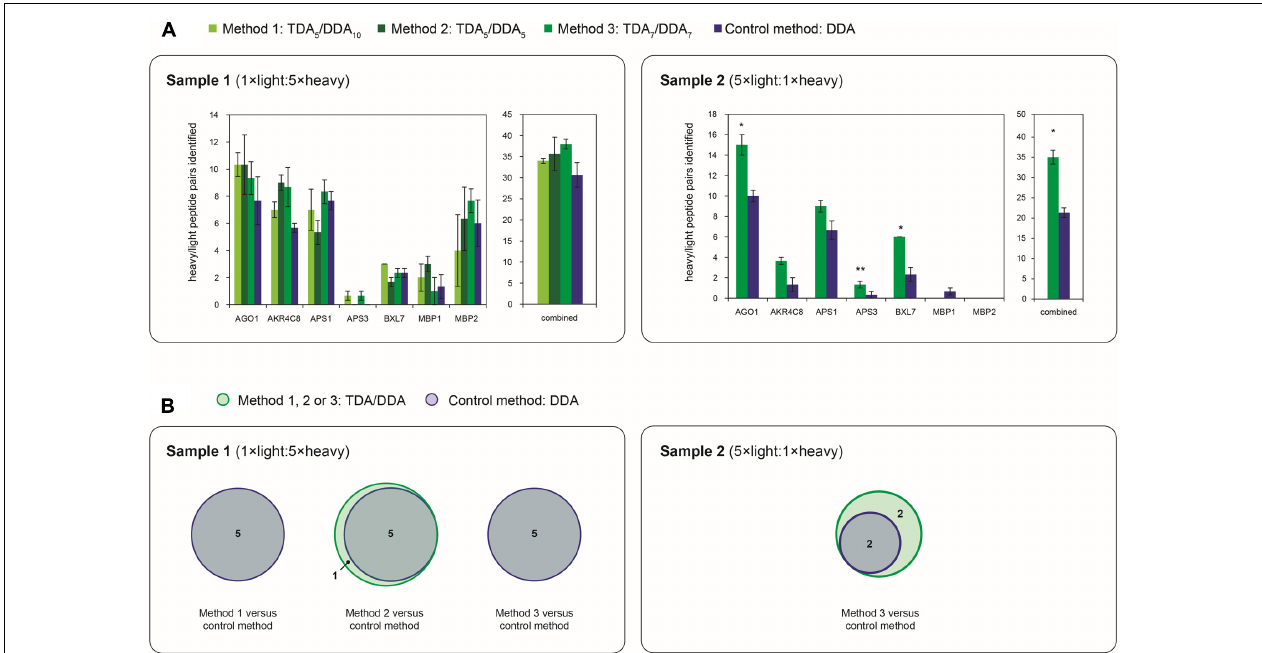
FIGURE 5 | Depth and reproducibility of relative quantification of the miRNA target proteins of Table 1 in TDA/DDA and DDA control method experiments. (A) Average numbers of heavy/light peptide pairs detected and quantified for each individual targeted protein, and for all targeted proteins combined, per technical replicate in each batch of LC-MS/MS experiments conducted on sample 1 (left) and sample 2 (right). Statistically significant differences between TDA/DDA and DDA control method experiments, as determined using 2-tailed t -tests, are labeled ∗ p < 0.05 or ∗∗ p < 0.01. (B) Numbers of targeted proteins quantified (from ≥ 2 heavy/light peptide pairs) across all three sets of technical replicates in TDA/DDA and DDA control method experiments conducted on sample 1 (left) and sample 2